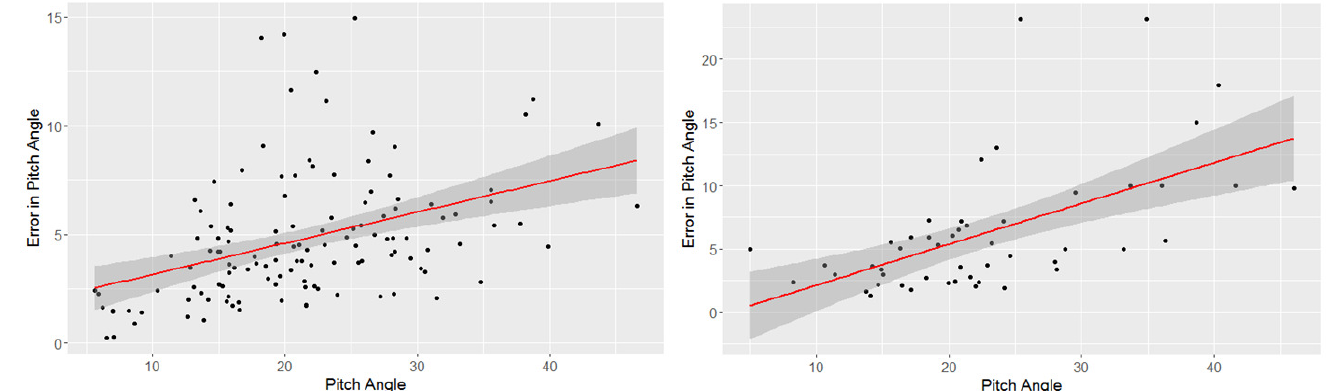
Figure 12. Measurements of pitch angle are heteroscedastic, i.e., δφ ∝ | φ | . ( Left ) δφ (uncertainty in pitch angle measurement) as a function of | φ | for the Davis et al. [53] sample. ( Right ) δφ as a function of | φ | for the faint galaxies sample. Linear fits of heteroscedasticity ( ) include shaded 95% confidence intervals. Both data sets show increasing measurement errors as a function of pitch angle absolute value. These graphs were generated via R scripts from Fox and Weisberg